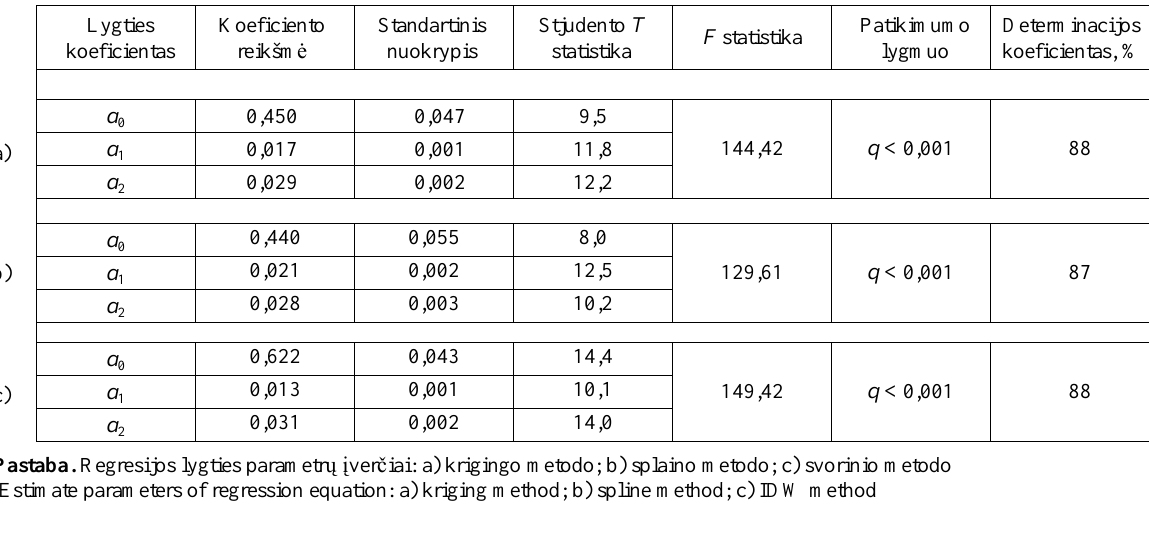
Table 2. Disperse analysis of regression equation